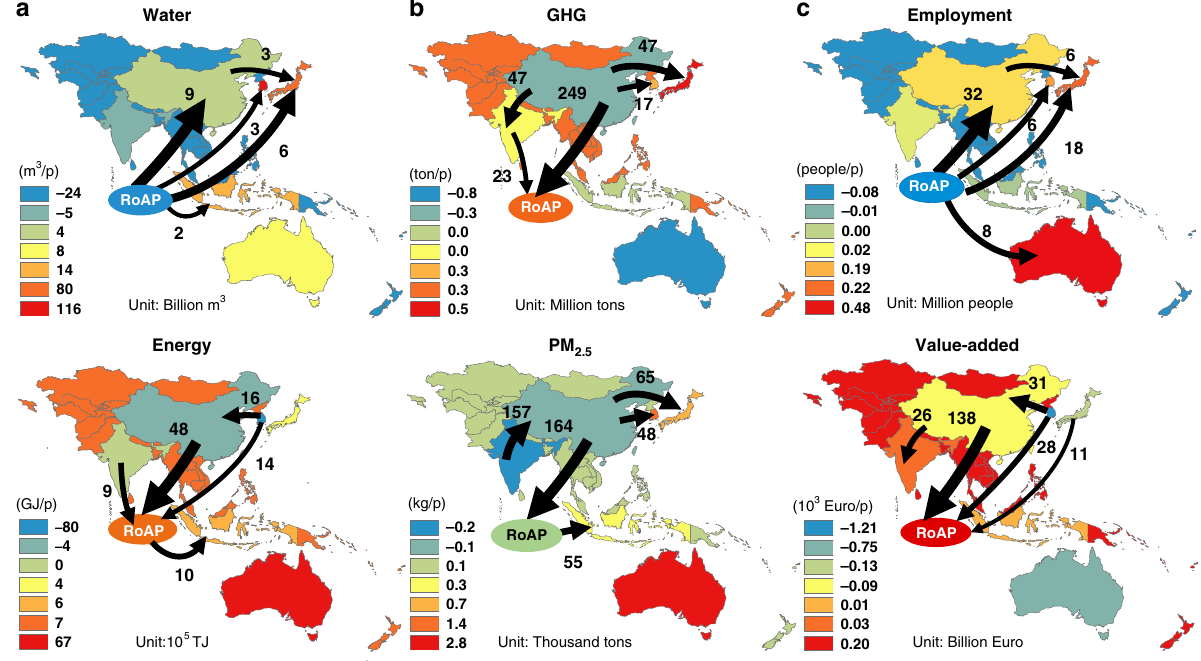
Fig. 2 Net environmental-social-economic virtual fl ows of the intra-APAC trade in 2015. The top fi ve net fl ows are shown for each footprint indicator, and fall into three panels a natural resource, b local and global environmental threats, c socio-economic effects. The width of the arrows in each panel represents the magnitude of the net fl ow within the APAC region. The background colors indicate the speci fi c net footprint (import-export) per capita of each region/country. The negative net footprint indicates net displacements (of resource use, emissions, labors, and economic value added) to other APAC countries/regions. Note, the background color and fl ows of Taiwan, China could not be shown on the